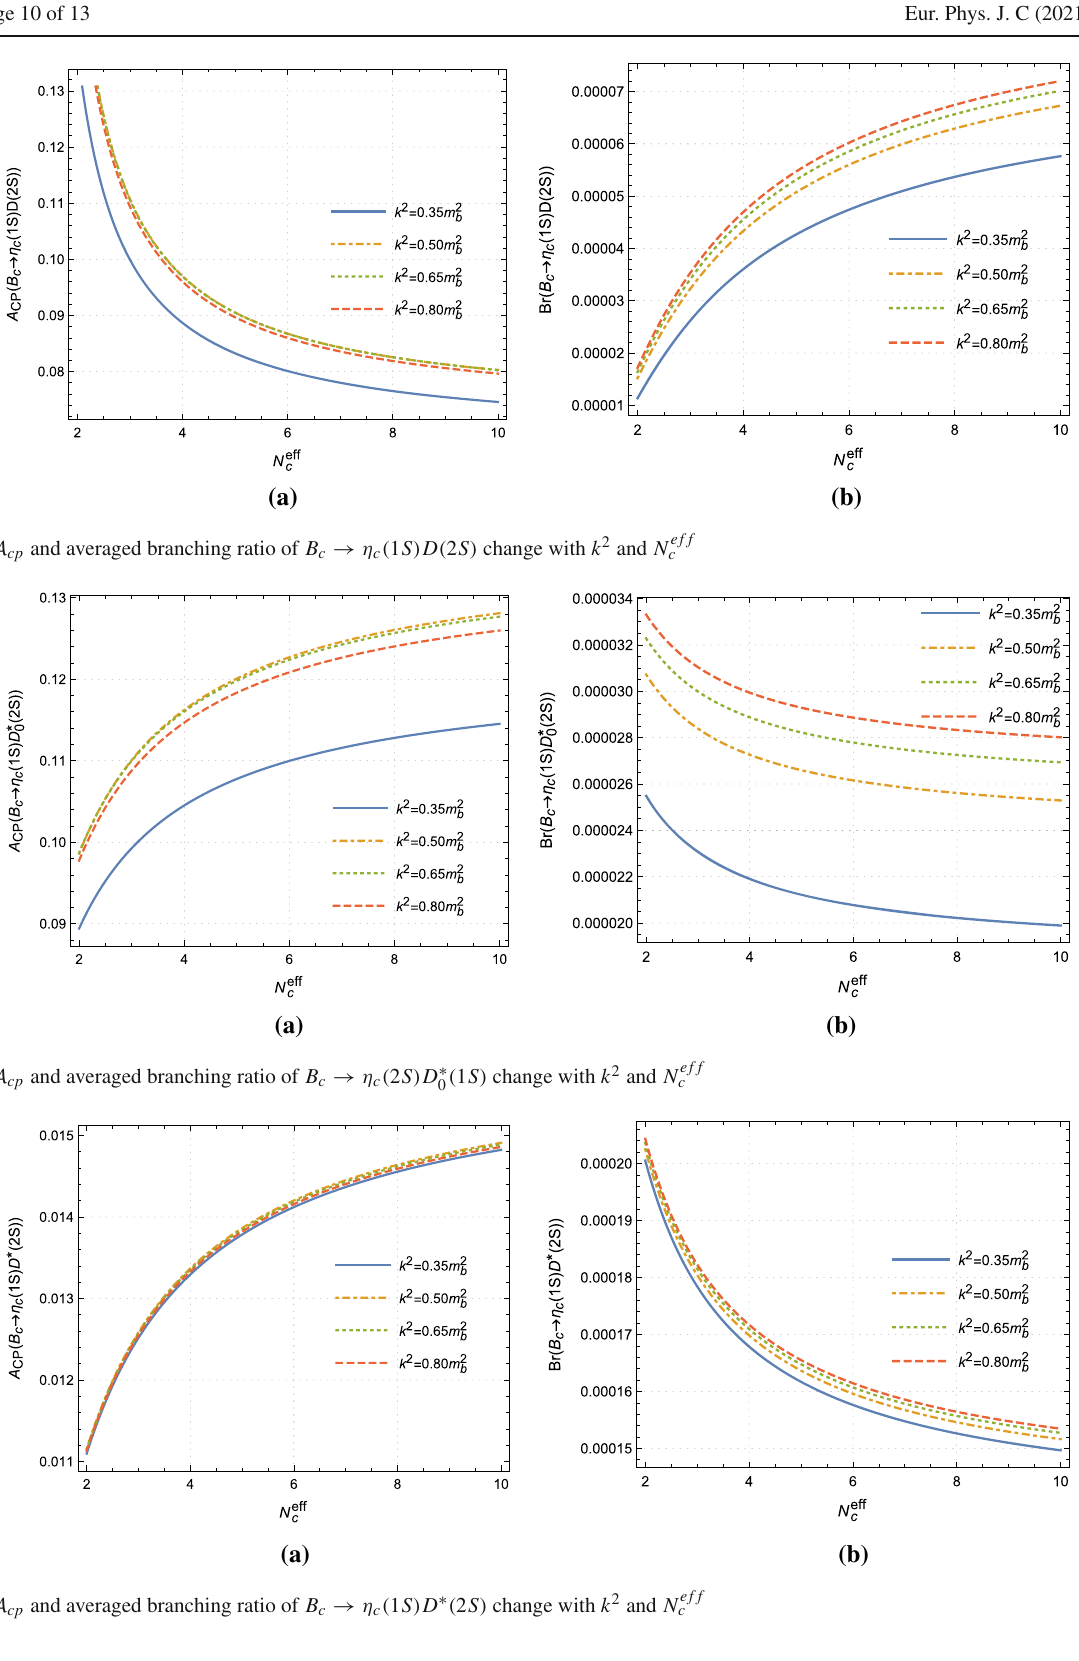
Fig. 8 A cp and averaged branching ratio of B c → η c ( 1 S ) D ∗ ( 2 S ) change with k 2 and N ef f